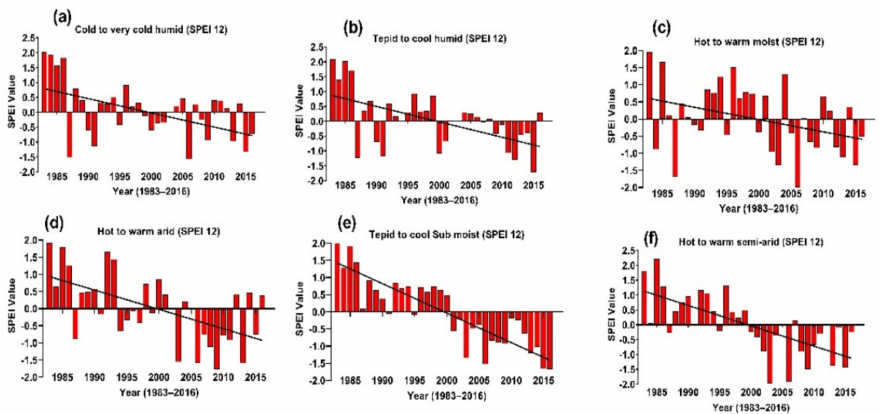
Figure 14. Annual trends of SPEI ( a – f ) over agroecological zones for the period